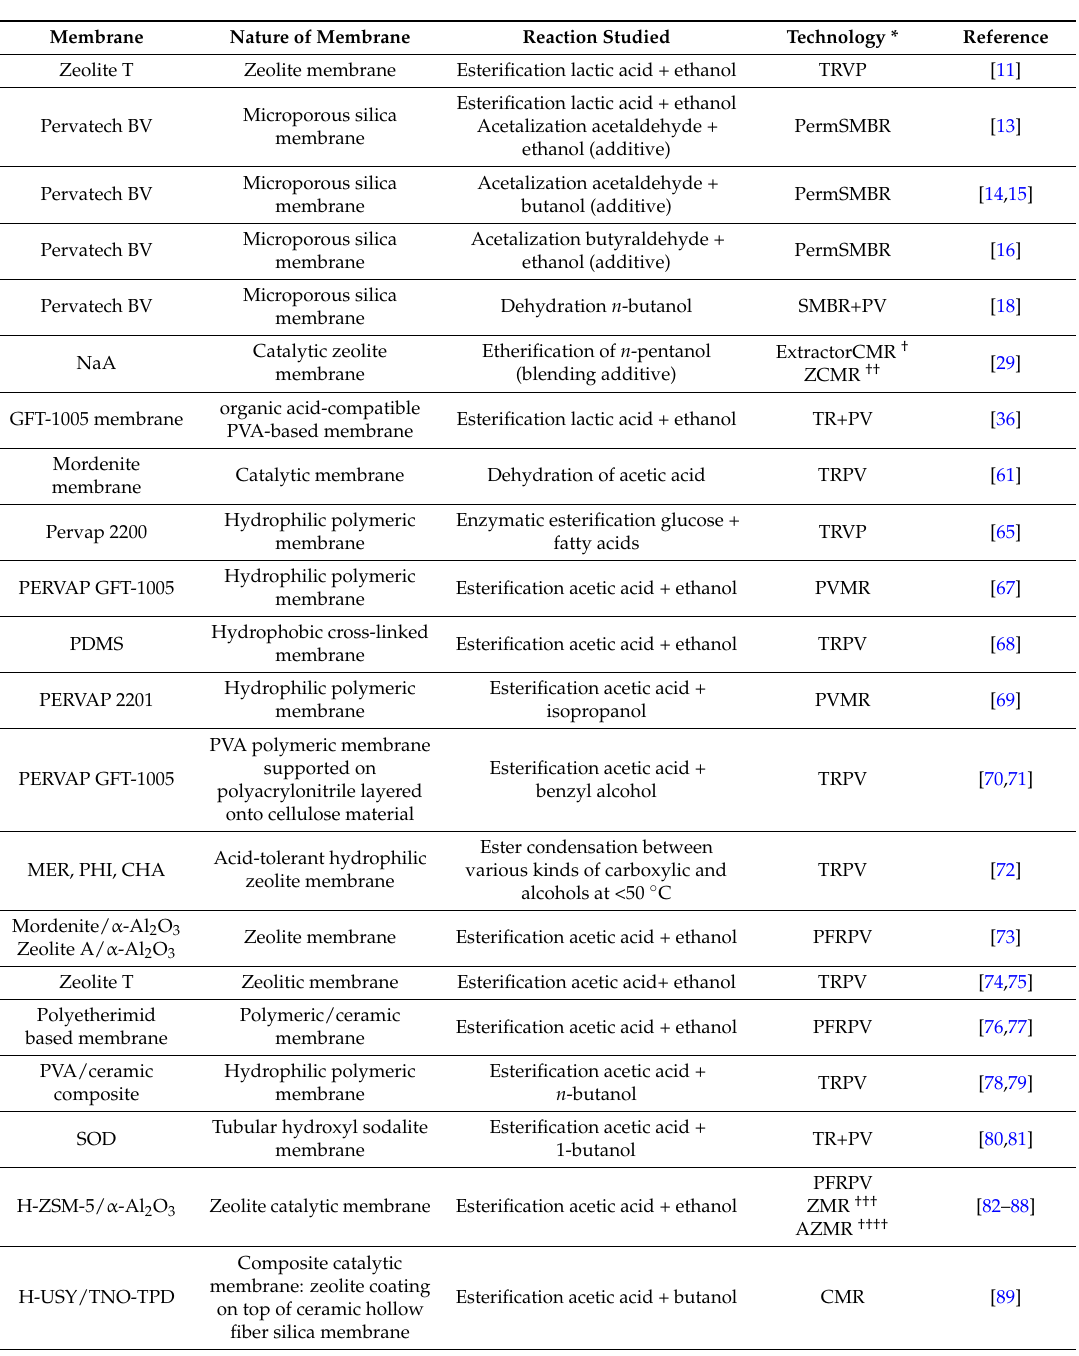
Table 3. PV and VP process